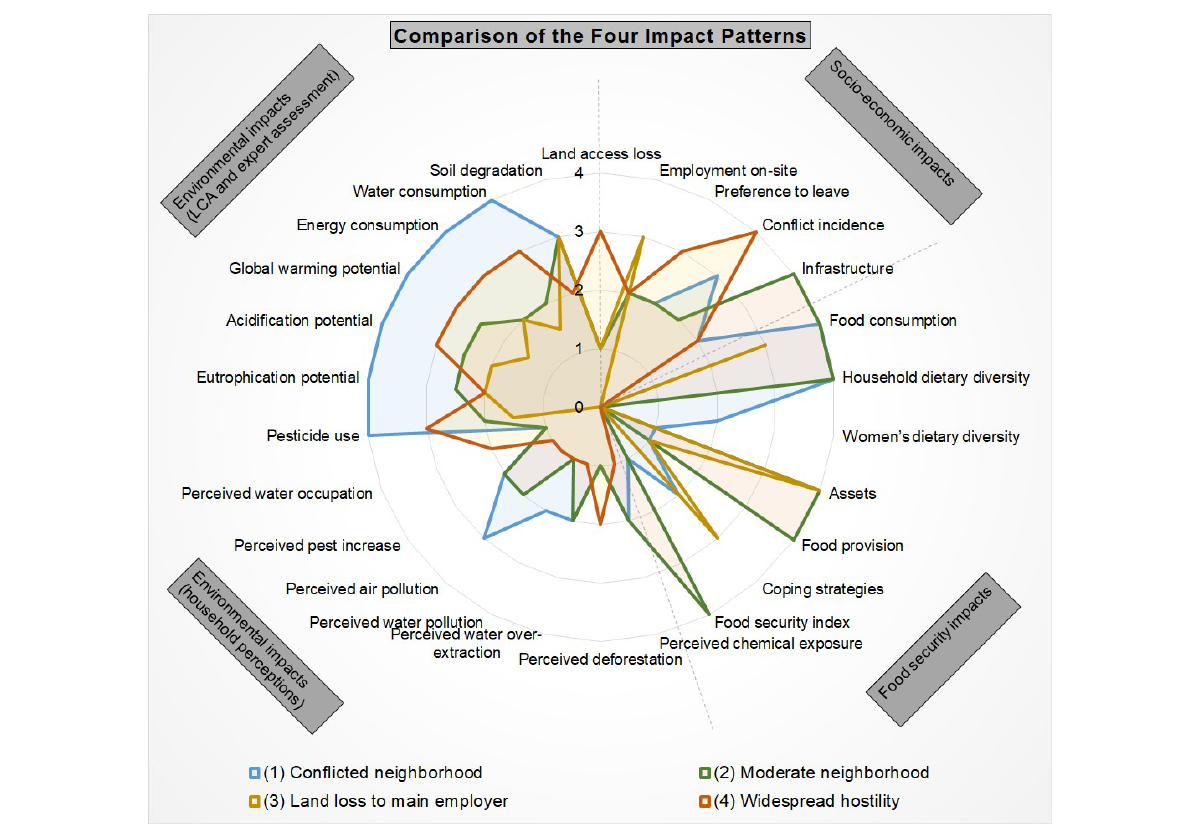
Fig. 3. Comparison of the four impact